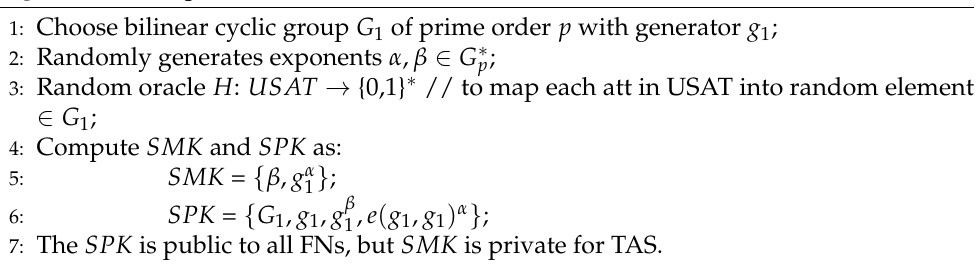
Algorithm 1 Setup ( λ ).